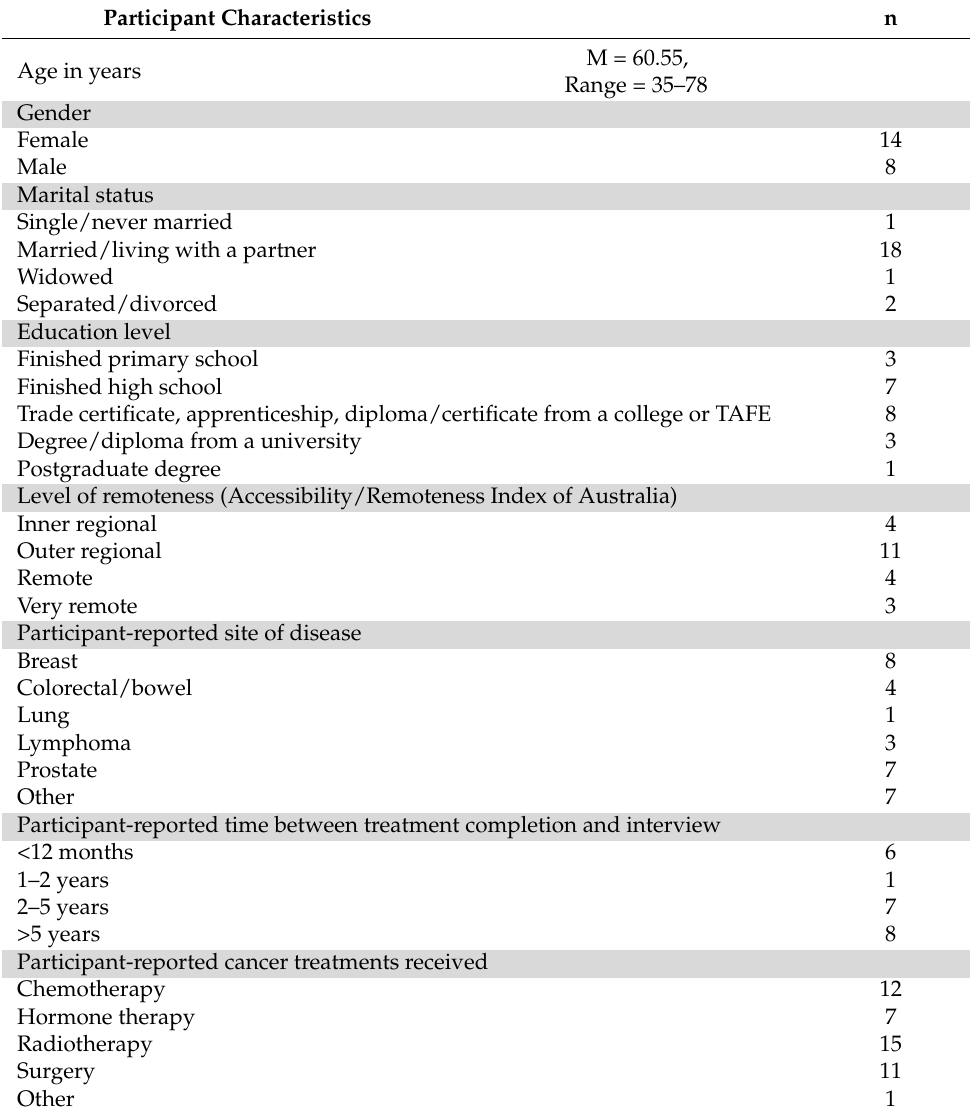
Table 2. Demographic and cancer history characteristics of the